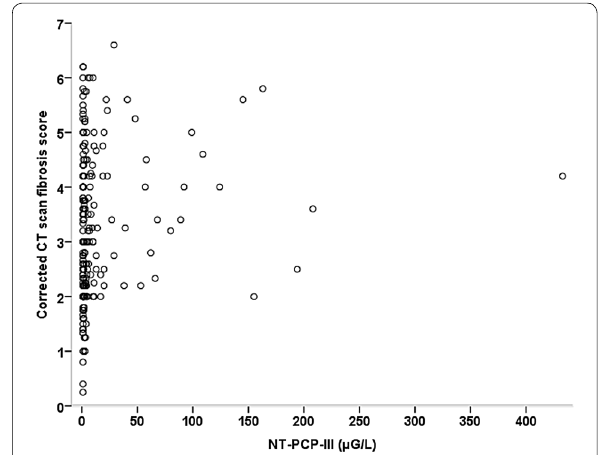
Fig. 2 Relationship between corrected CT scan fibrosis score